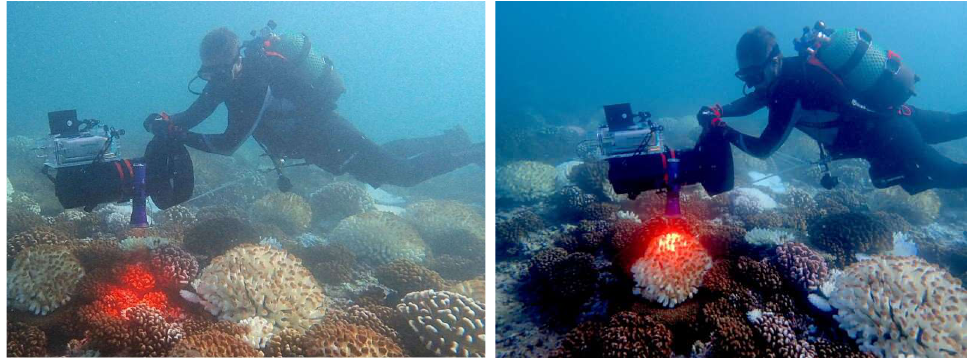
Figure A2. Benthic spectral data field measurements.